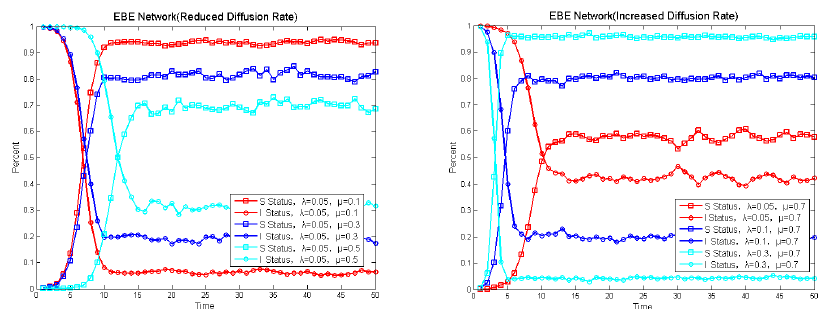
Figure 12. Influence of diffusion rate on spreading in three-layer EBE network.